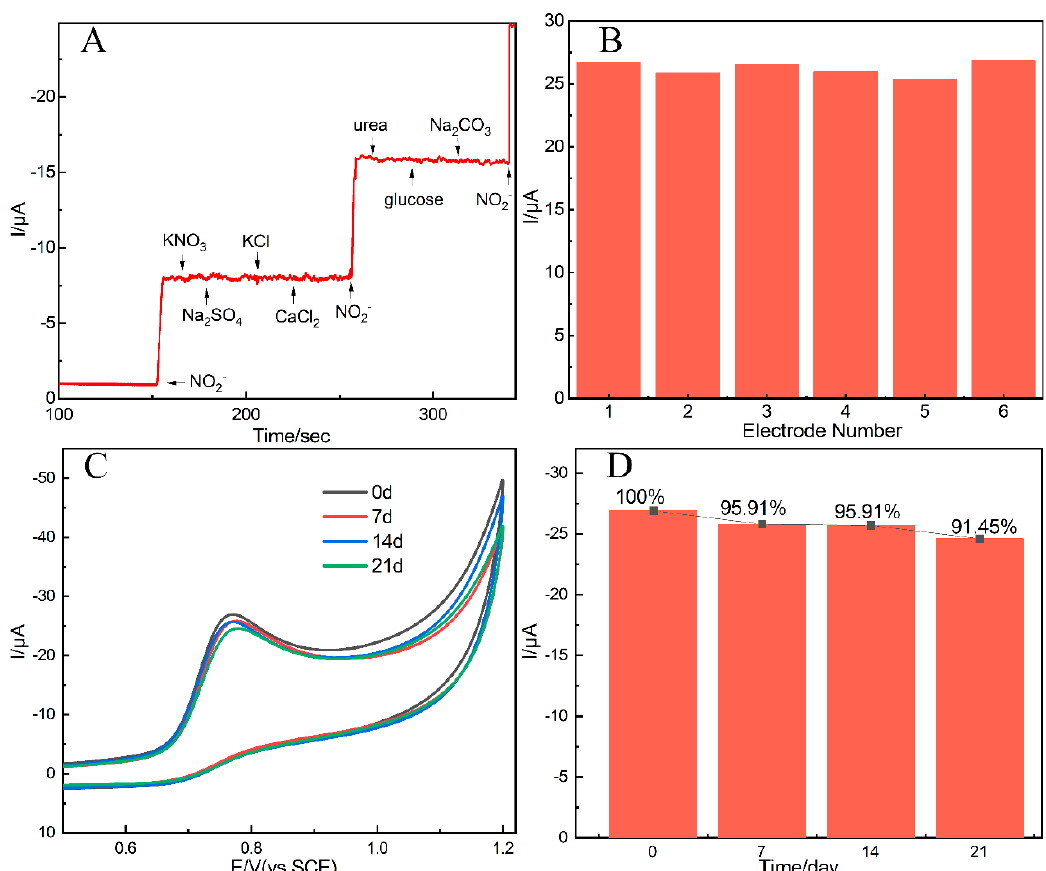
Figure 8. ( A ) The i-t curves of MoS 2 /MWCNT-COOH/GCE in 0.1 M PBS added with nitrite (250 μ M) and other interfering chemicals (500 μ M, respectively), ( B ) the histograms of six MoS 2 /MWCNT- COOH/GCEs in 0.1 M PBS with 500 μ M nitrite, the CV curves ( C ) and the current histograms ( D ) of MoS 2 /MWCNT-COOH/GCE in 0.1 M PBS with 500 μ M nitrite MoS 2 /MWCNT-COOH/GCE under different preserve time (0 d, 7 d, 14 d, and 21 d).